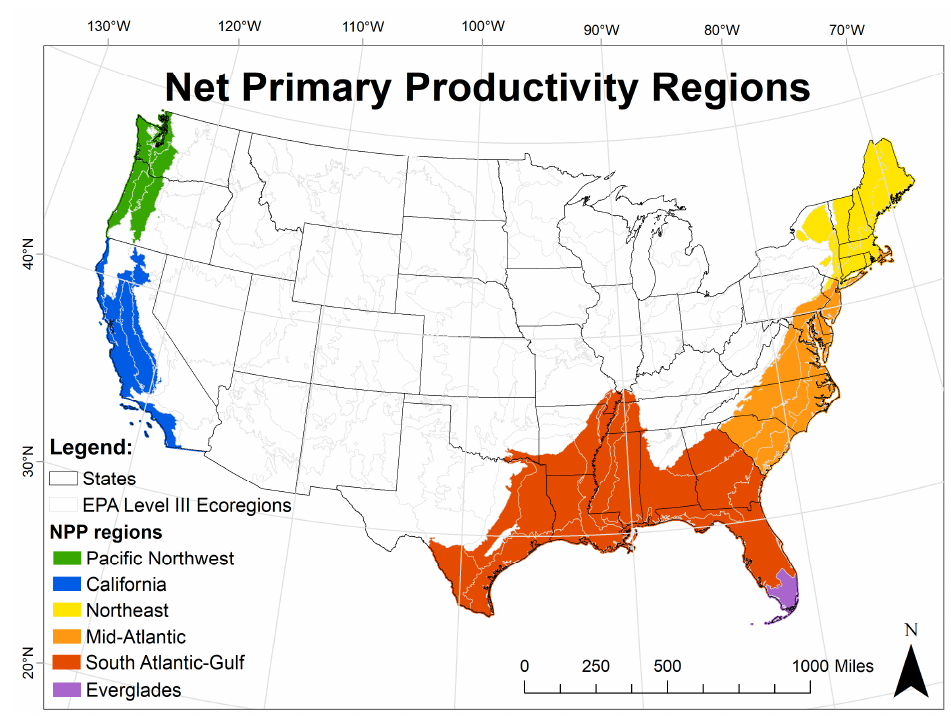
Figure 1. Regions used to study wetland biomass and net primary productivity (NPP).